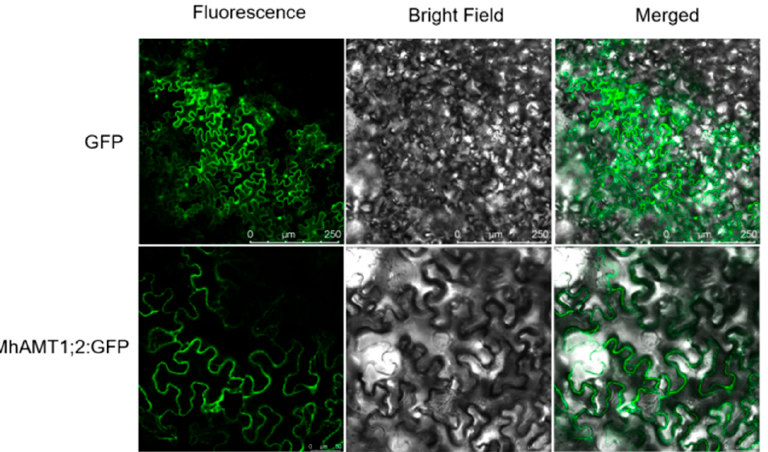
Figure 6. Subcellular localization of transiently expressed MhAMT1;2:GFP in tobacco leaf cells. GFP: pC1300-GFP; MhAMT1;2:GFP: pC1300-MhAMT1;2:GFP. Fluorescence: image of GFP expression under confocal microscopy; Bright-field: image of GFP expression under bright-field microscopy; Merged: overlaid image of corresponding bright-field and fluorescence images.